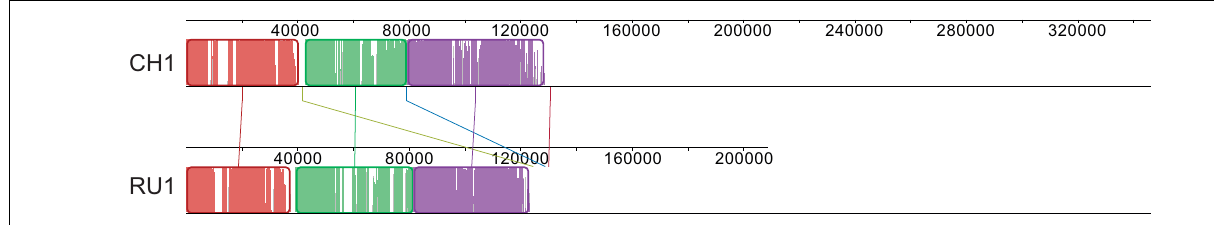
as local colinear blocks (colored) filled with a similarity plot. Height of the similarity plot indicates nucleotide identity of both